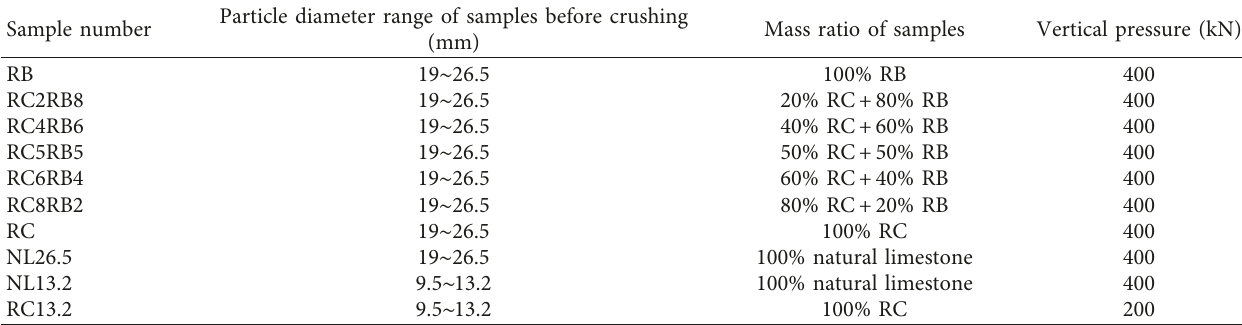
Figure 2: Aggregate samples. (a) Recycled concrete aggregates. (b) Recycled clay brick aggregates. (c) Limestone Table 1: Test conditions.